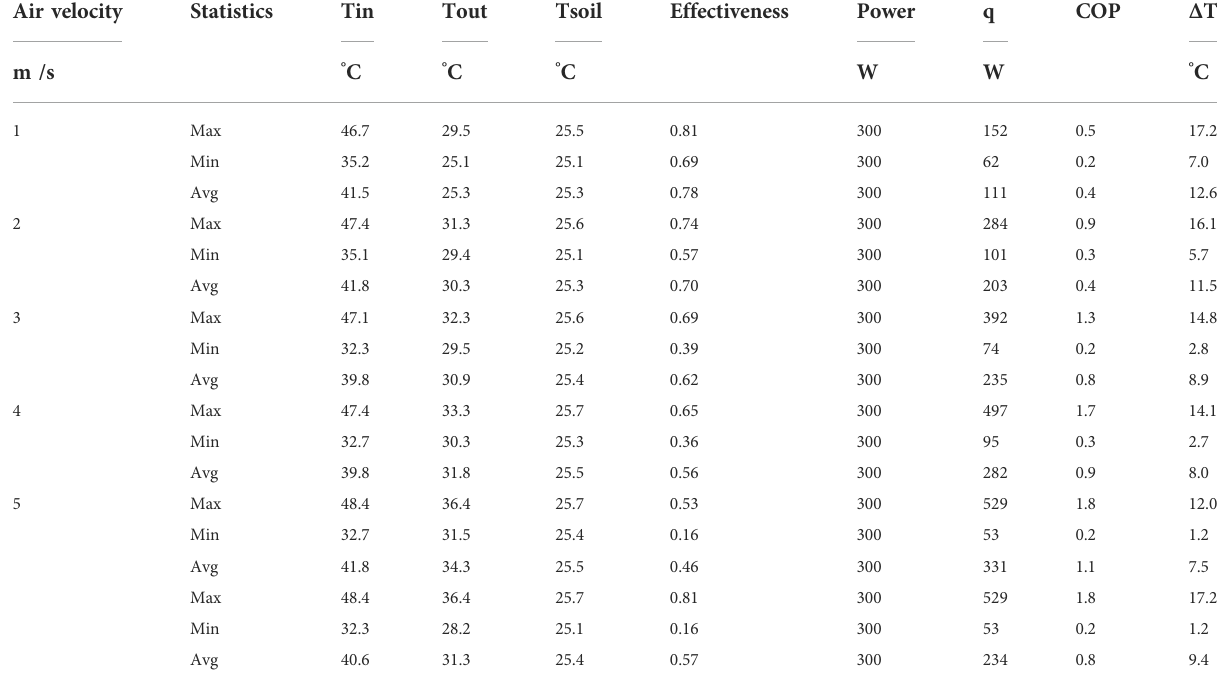
TABLE 2 Computed parameters at different experimental temperatures during June.